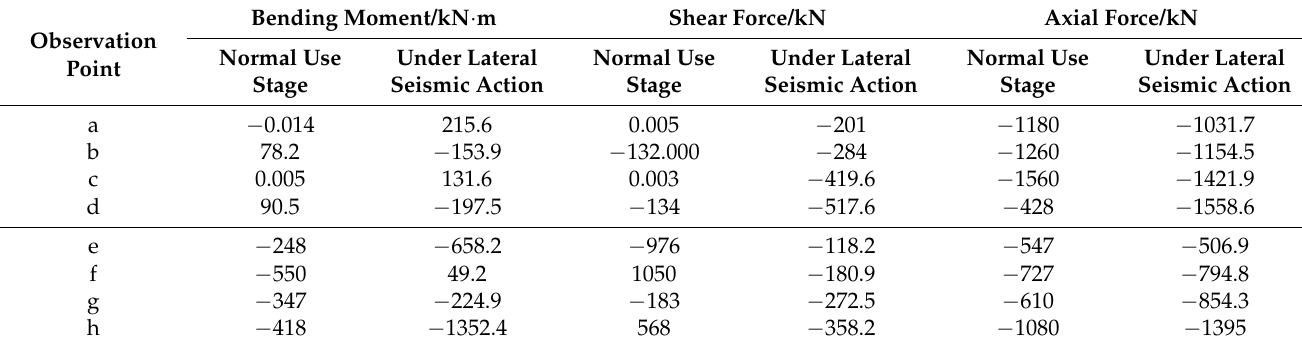
Table 4. Comparison of structural internal forces in normal